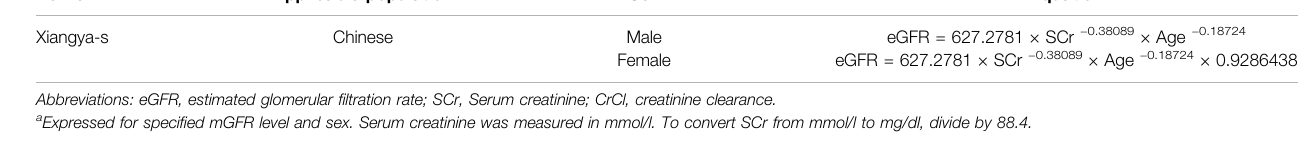
TABLE 2 | Performance of the Xiangya-s equation in patients with mGFR < 60 ml/min/1.73 m 2 of the development and internal validation cohort. Characteristic and performance of Xiangya-s equation Mean mGFR (SD), mL/min/1.73 m 2